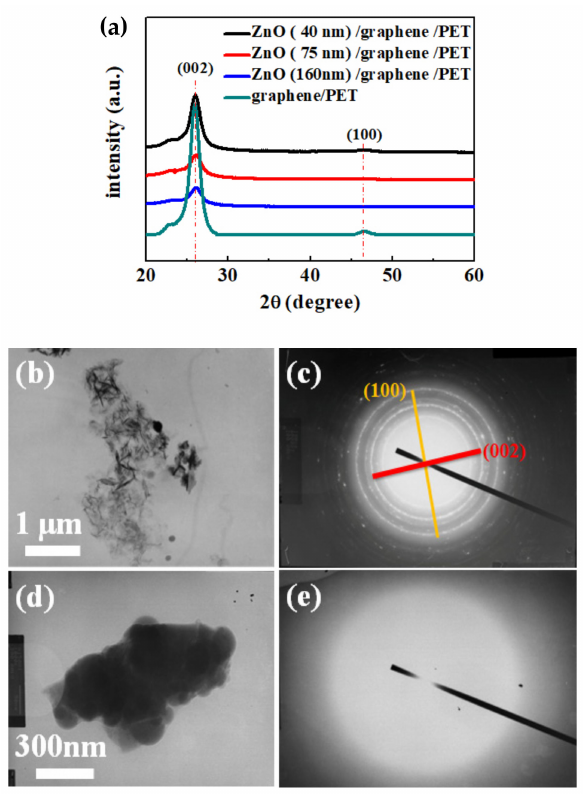
Figure 4. ( a ) X-ray diffraction spectra of graphene/PET and ZnO (40, 75, and 160 nm thick- ness)/graphene/PET; ( b , c ) TEM image and SAED pattern of graphene/PET; ( d , e ) TEM image and SAED pattern of